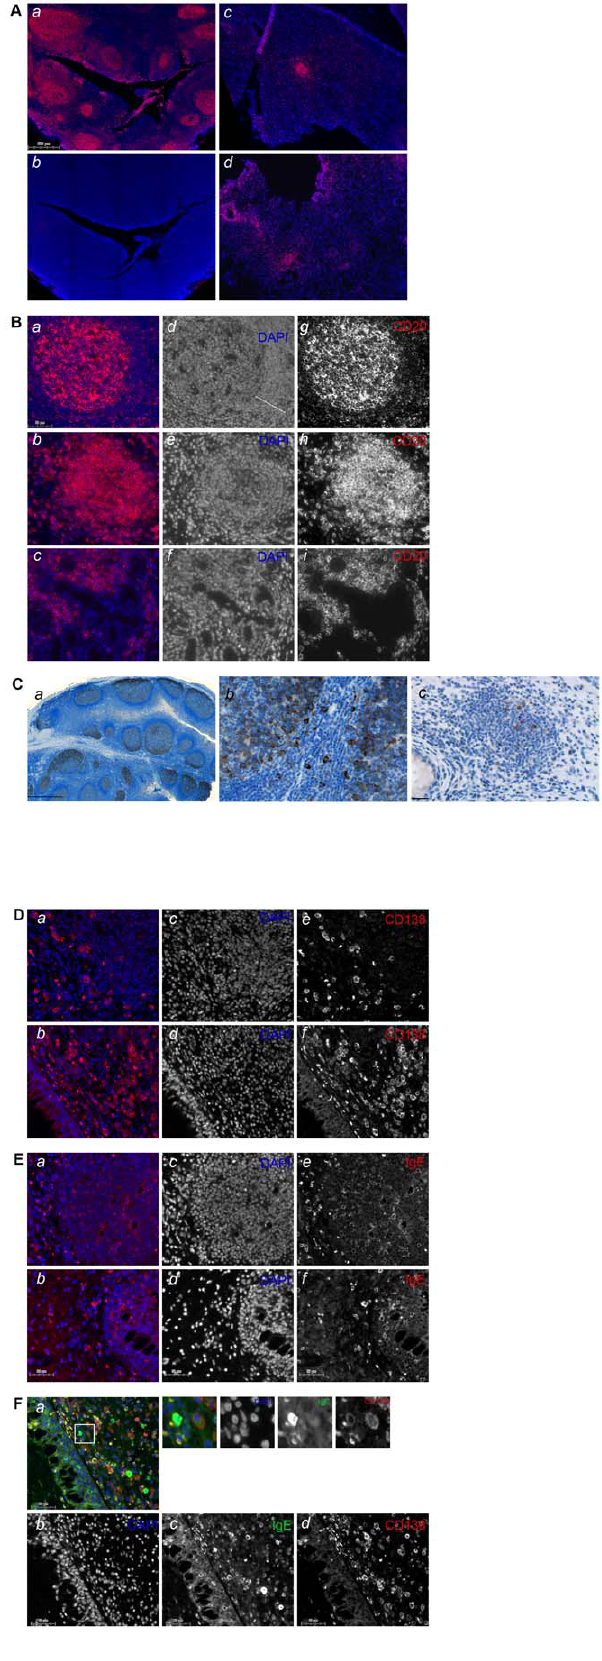
Figure 2. AID expression in nasal polyp tissues assessed by in situ immunostaining. (A) CD20 staining in fully developed GCs in tonsil tissue (CD20, a; isotype control, b) and two representative NP specimens (c, d); scale bar: 500 m m. (B) CD20 staining: higher power views of GC in tonsil (a) and of two types of B cell infiltrates in NP as prominent follicles (b) and accumulations around the glandular structures (c) are shown. In addition to the merged images (a, b, c; red channel for CD20 and blue channel for DAPI), pictures of individual channels are included (d, e, f for DAPI; g, h, i for CD20); the presence of the mantel zone in fully established GC within tonsil tissues is indicated by a white dotted line. Scale bar: 50 m m. In Figure 2, the individual channels are shown in black/white, whereas merged images are shown in color. (C) AID-positive GCs in tonsil tissue (a, the low-power view; b, the higher-power view) and follicular structures within NP with AID- positive cells (c) are shown; Scale bar for a is 1000 m m; scale bar for b, c is 50 m m. (D) Two areas representative for accumulation of CD138- positive cells within NP tissues are shown: around follicular structures (merged, a; DAPI, c; CD138,e) and in the close proximity to the boarder of NP body (merged, b; DAPI, d; CD138, f). Scale bar: 50 m m. (E) Representative pictures of IgE-positive cells detected within follicular structures and their surrounding cell populations and within B cell aggregates around the glandular structures (merged a, b; DAPI, c, d; IgE, e, f). Scale bar: 50 m m. (F) Double staining of IgE (green) and CD138 (red) within NP (merged a; DAPI, b; IgE, c; CD138, d); insert: example of double positive B cell is shown. Scale bar: 50 m m.